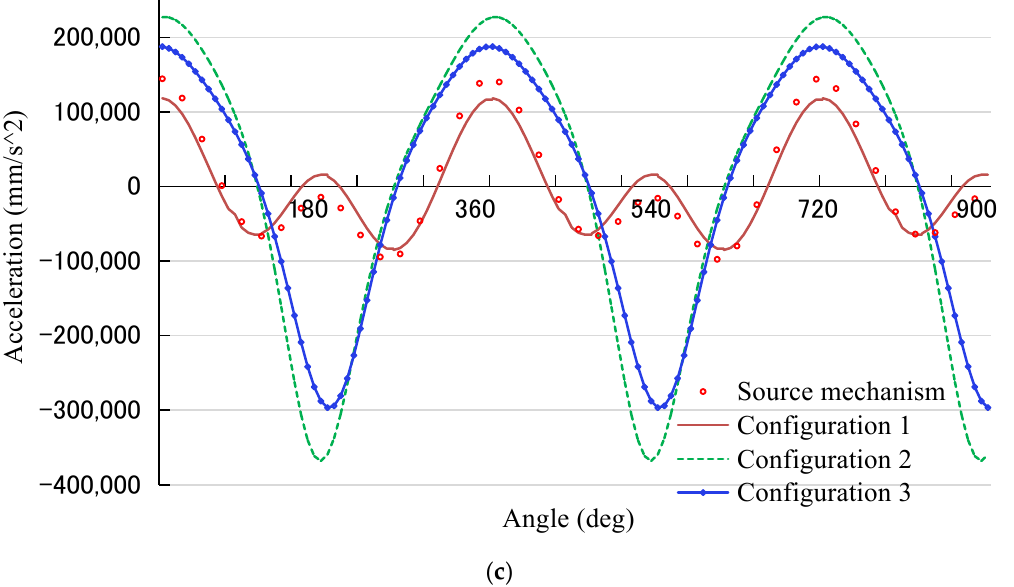
Figure 13. Forward and backward movement curves of the feed dog. Forward and backward ( a ) movement displacement, ( b ) movement velocity, and ( c ) movement acceleration of the feed dog.